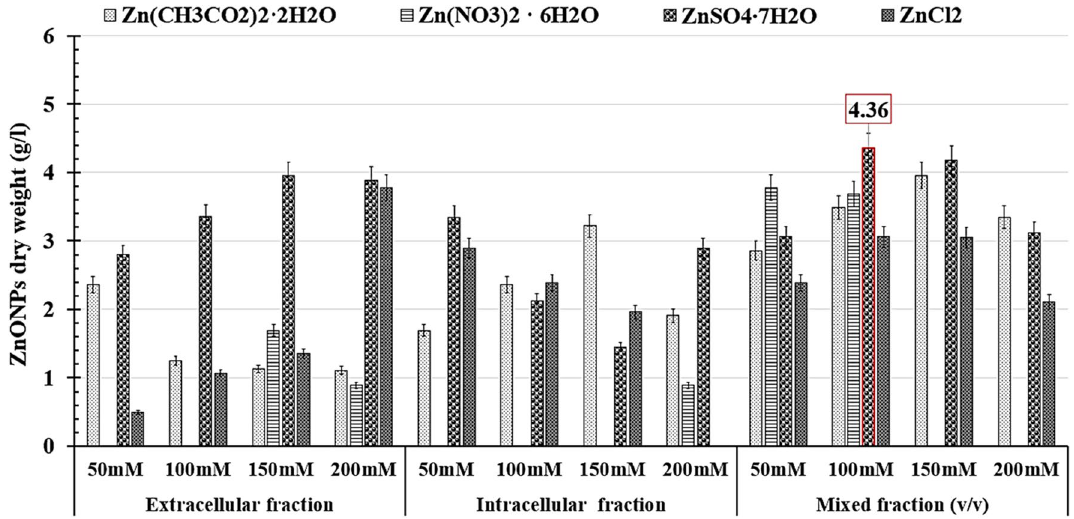
Figure 2. Represents the maximum yield of biosynthetic ZnO NPs using Zn (CH 3 COO) 2. 2H 2 O, Zn